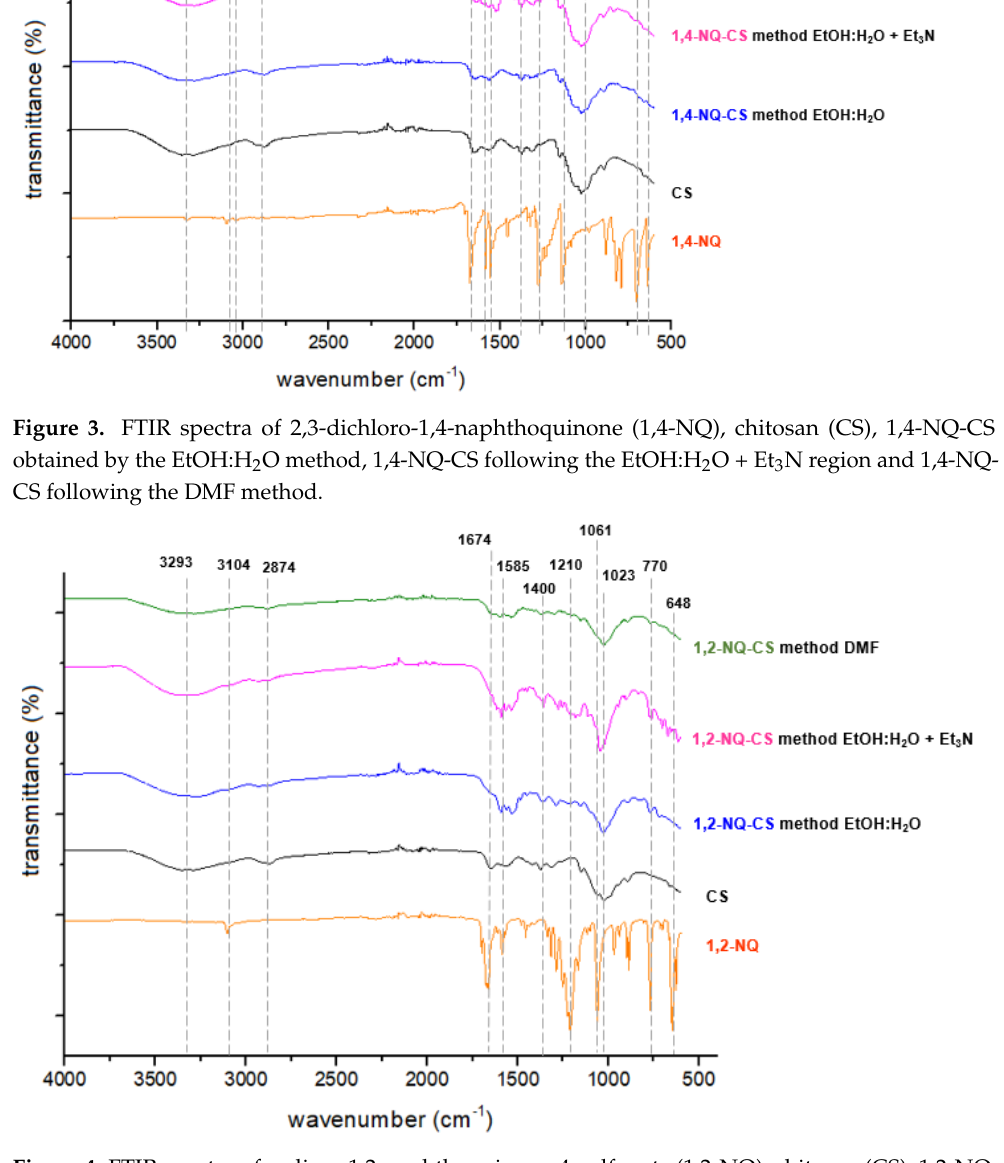
Figure 4. FTIR spectra of sodium 1,2-naphthoquinone-4-sulfonate (1,2-NQ), chitosan (CS),